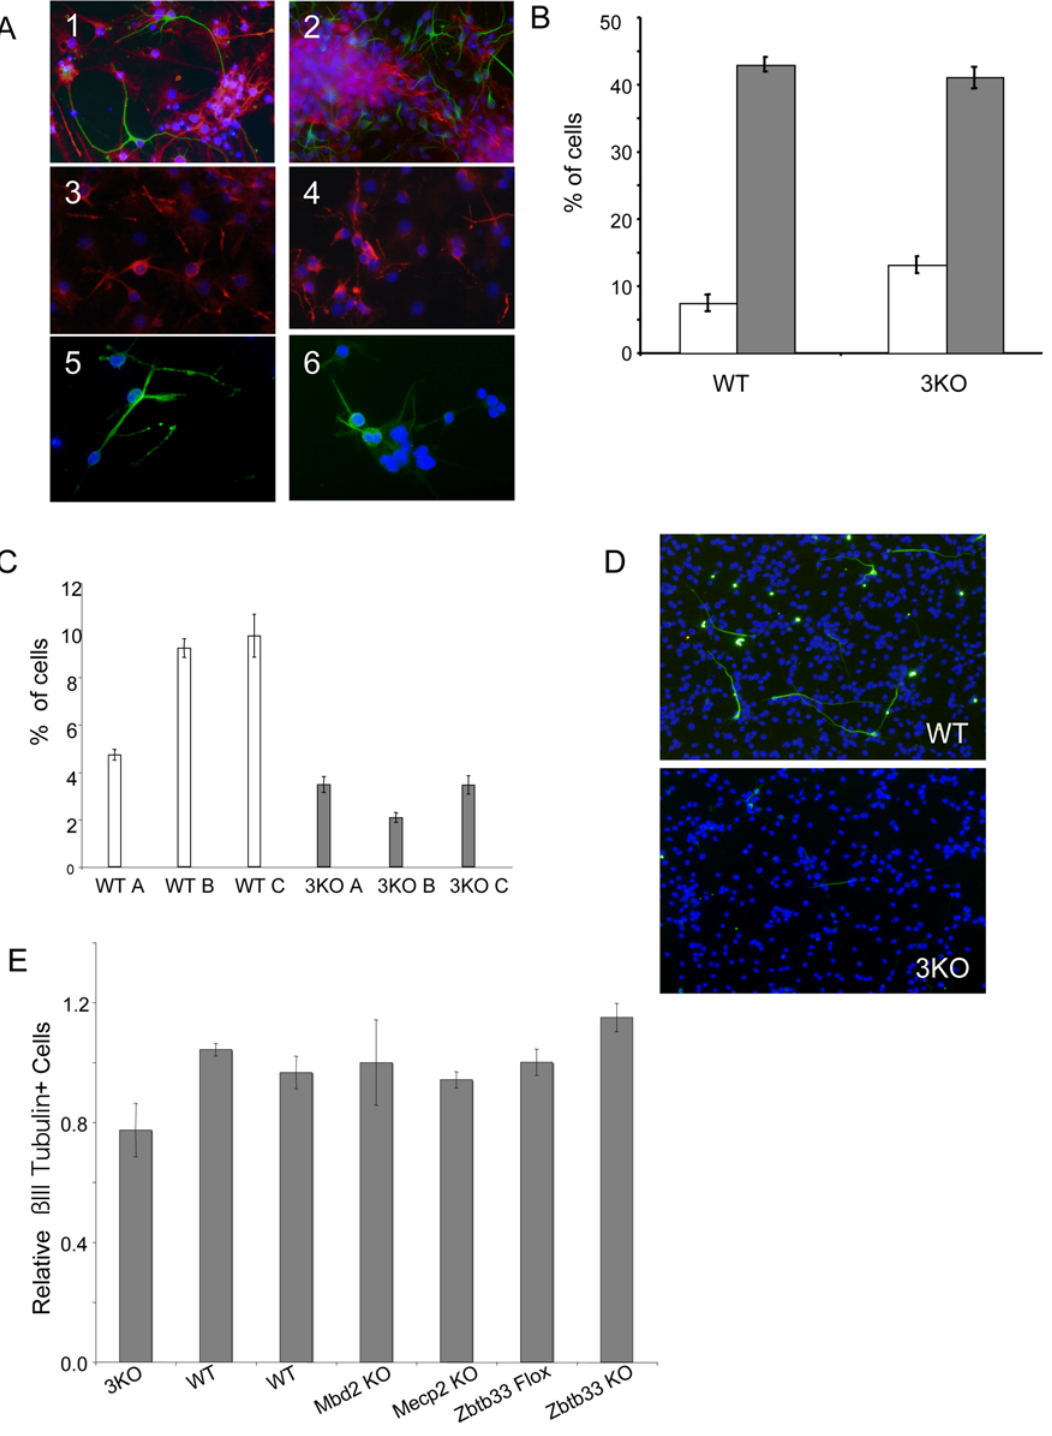
Figure 5. Neural differentiation of 3KO NS Cells. NS cells were cultured for 15 days in neuronal differentiation conditions and immunostained for ß-tubulin III (green) and Gfap (red) in panels 1 and 2, Map2 in panels 3 and 4, and for Gad67 (green), a marker of Gabaergic neurons, in panels 5 and 6. Cells were counterstained in Dapi (blue). Panels 1, 3, and 5: wild-type NS cells; panels 2, 4, and 6: 3KO NS cells. B. Quantitation of the number of ß-tubulinIII expressing (white bars) and Gfap-expressing (grey bars) cells in 14 day neural differentiation cultures from wild-type (left) and 3KO (right) NS cell cultures. Error bars represent SEM from three independent experiments. C. Quantitation of the number of ß-tubulinIII positive cells present in NS cell cultures after seven days’ neuronal differentiation. Data is shown for three different wild-type and three different 3KO NS cell lines. Error bars represent SEM from at least three independent experiments. The difference seen between the wild-type and 3KO lines is highly statistically significant (p , 0.0024, Bonferroni). D. Images of 7 day neural cultures from wild-type (left) or 3KO (right) NS cells, stained for ß-tubulin III (green) and Dapi (blue). E. Relative percentage of ß-tubulin III positive cells present in NS cell cultures of indicated genotype after eight days’ neuronal differentiation. Error bars represent SEM from at least four independent fields of cells. All cell lines were derived from E14.5 cortex except those labeled ‘‘ Zbtb33 Flox’’ and ‘‘ Zbtb33 KO’’, which are ES cell-derived NS lines, with the Zbtb33 KO line having been derived from the Zbtb33 Flox line by Cre-transfection and gene deletion. Hence data for the Zbtb33 Flox line is included as an appropriate wild-type control for the Zbtb33 -null NS line. doi:10.1371/journal.pone.0004315.g005 PLoS ONE |